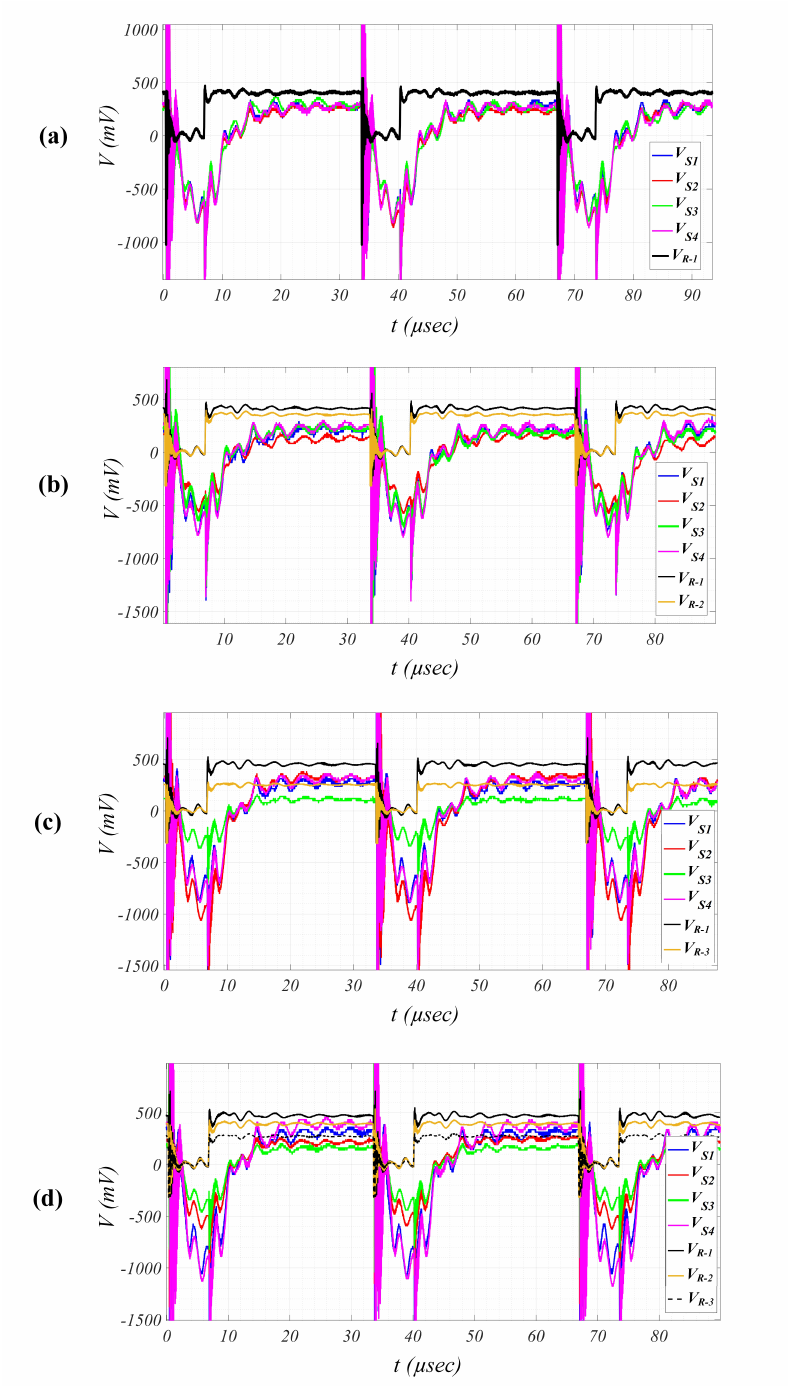
Figure 14. Sensor array calibration in four different current sharing conditions, ( a ) normal condition, ( b ) 20% reduction in path No.1 current conduction capability, ( c ) 80% reduction in path No.3 current conduction capability, and ( d ) 20% reduction in path No.1 and 80% reduction in path No.3 current conduction